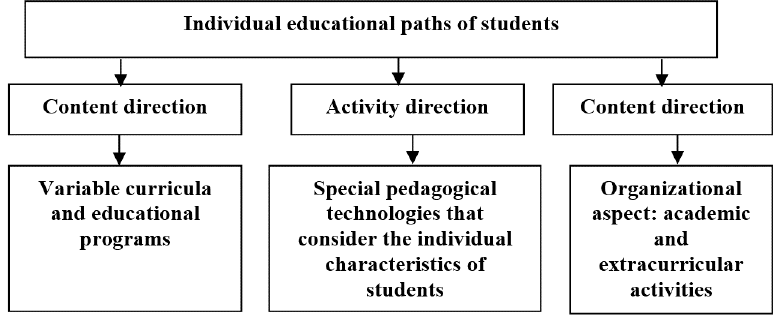
Fig. 2. Individual educational paths of